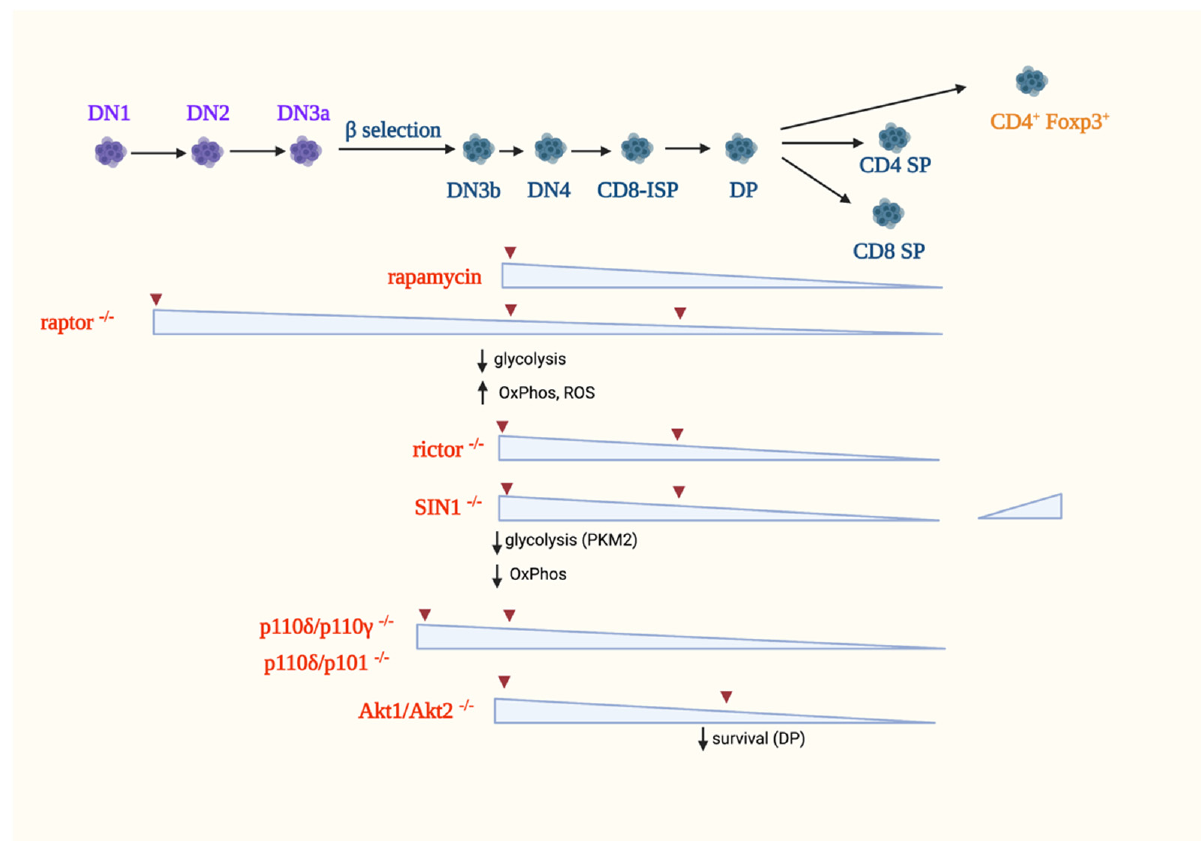
Figure 4. Effect of mTOR signaling disruption on metabolism and early αβ -T-cell development. Gene disruption or rapamycin treatment decrease the thymocyte numbers (encompassing stages indicated by blue triangles; downward slope indicates a decrease, while upward slope represents an increase) due to impaired progression at specific stages (stage of impairment indicated by small, brown triangles). In contrast, SIN1 disruption increases the tTreg (CD4 + Foxp3 + ) numbers.